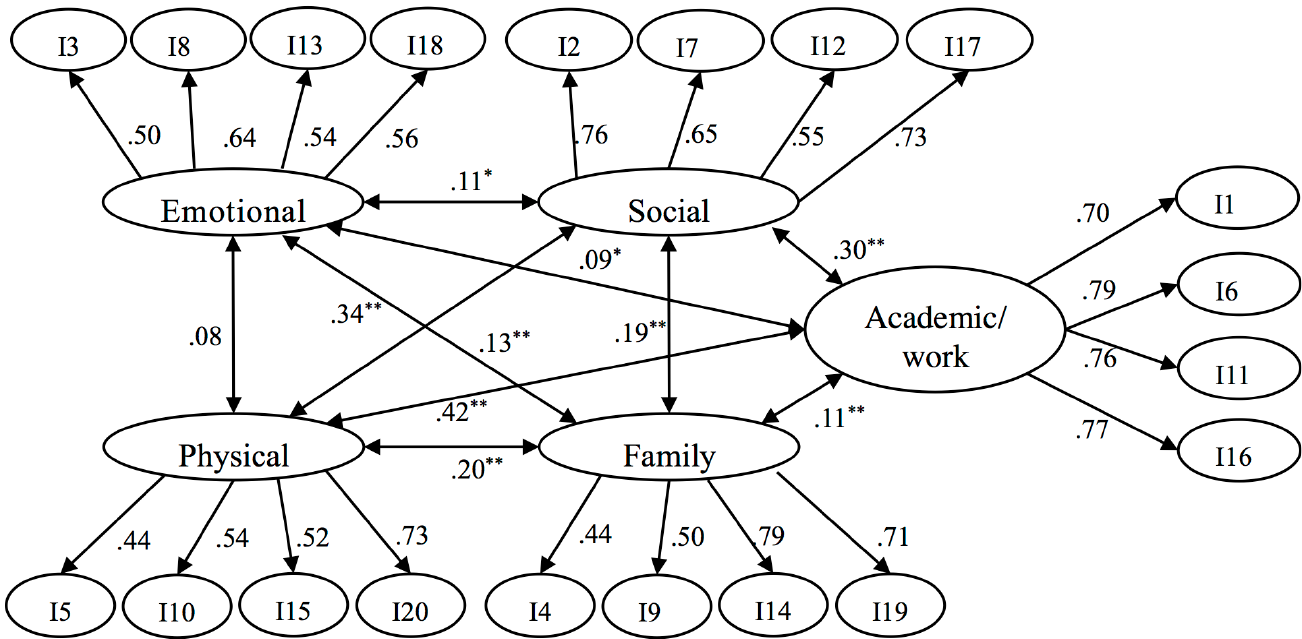
Figure 1. CFA structure for the AF5-brief scale.